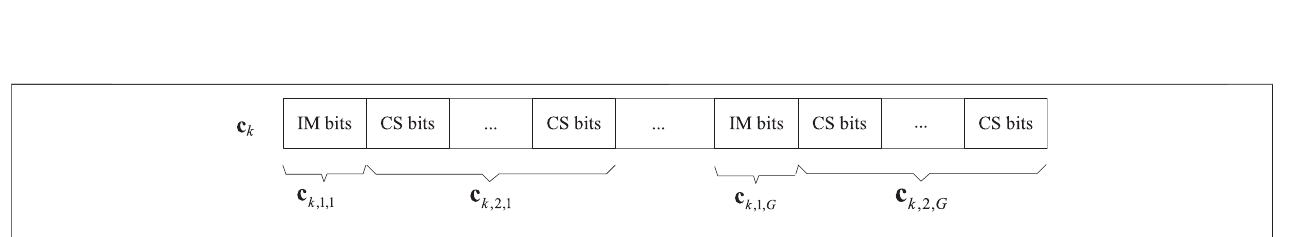
FIGURE 4 | Structure of coded bit sequence c k in the proposed IM-aided URA.